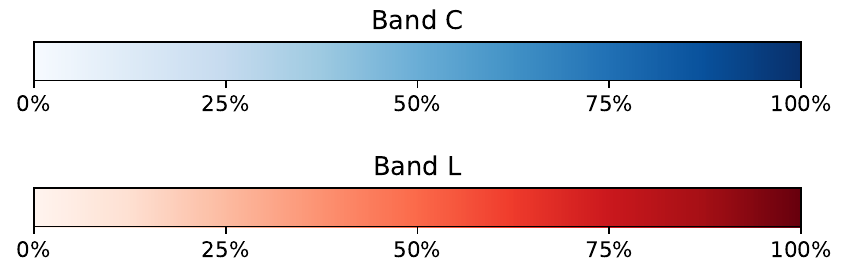
Figure 16. The scale showing the use of the C and L bands for the networks shown on the maps